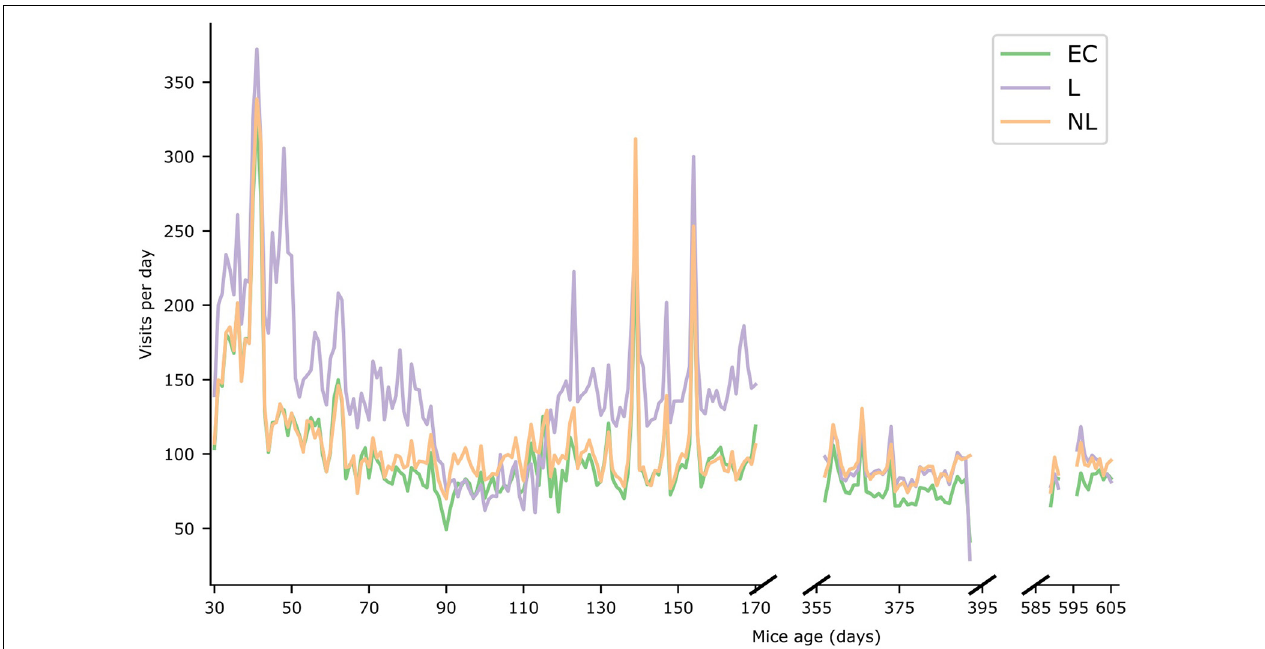
FIGURE 5 | Foraging behavior. Number of visits per day during the three IntelliCage phases. The X-axis represents the age of the mice (in days). The average value of the three different treatment groups are shown for the three IntelliCage phases.